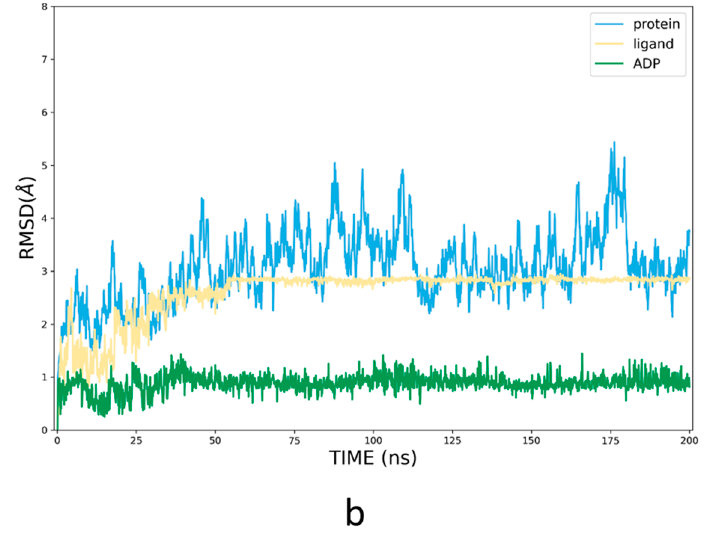
Figure 5. RMSD values plotted relative to the first frame (in Å) of the production phase based on the MD trajectories of ( a ) AF model 4 bound to ADP and ( b ) AF model 4 bound to ADP and MCC950. Blue line: C α RMSDs of the protein; green and yellow lines: heavy-atom RMSDs of ADP and the ligand, respectively.